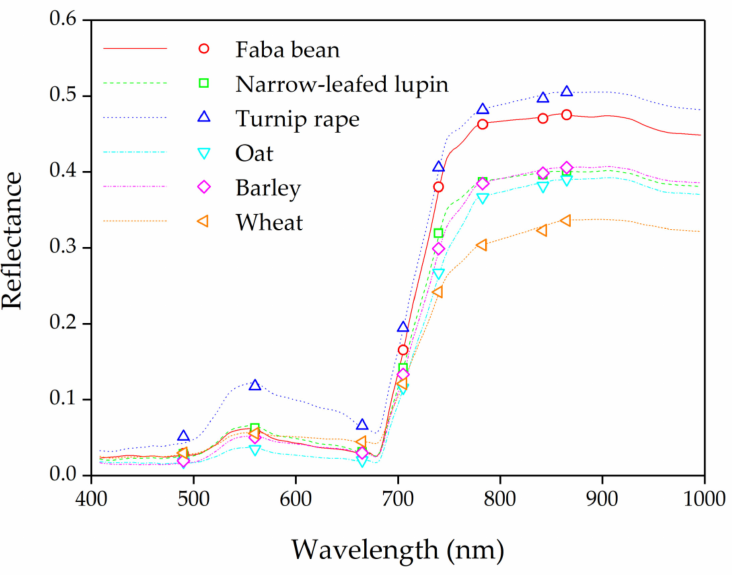
Figure 2. Spectral reflectance of the six crop species used in the study. Table 2. Eight Sentinel-2 bands invisible and NIR spectral regions. The band name refers to the names used in Table